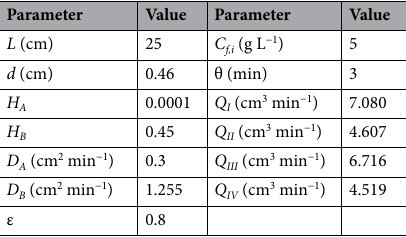
Table 2. The initial parameters for